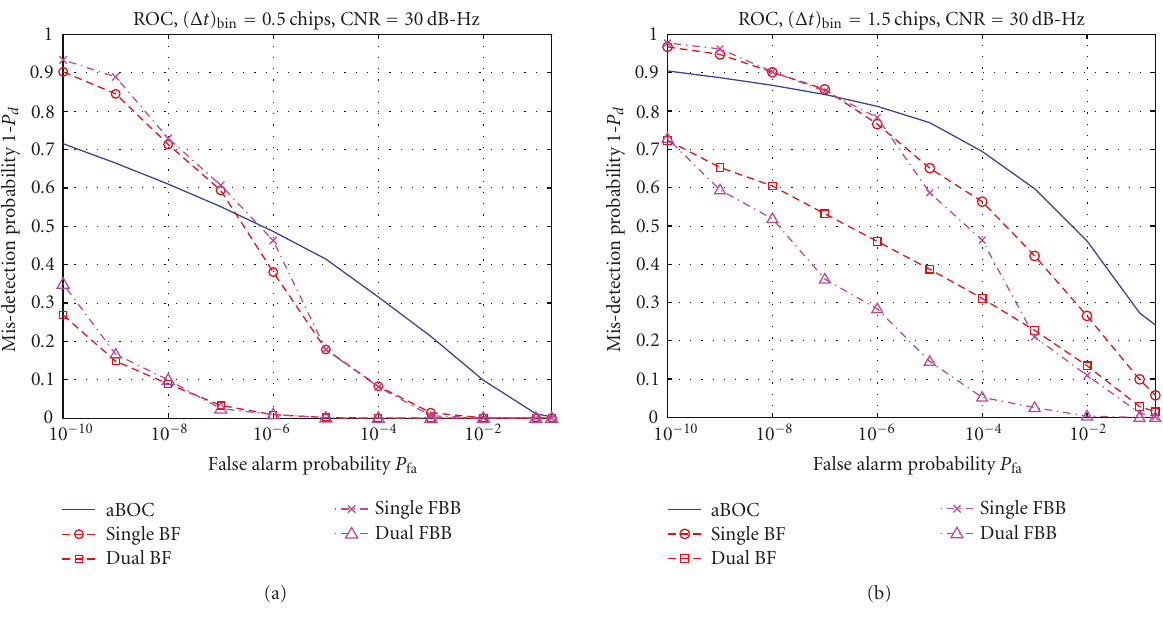
= 0 . 5 chips; right bin